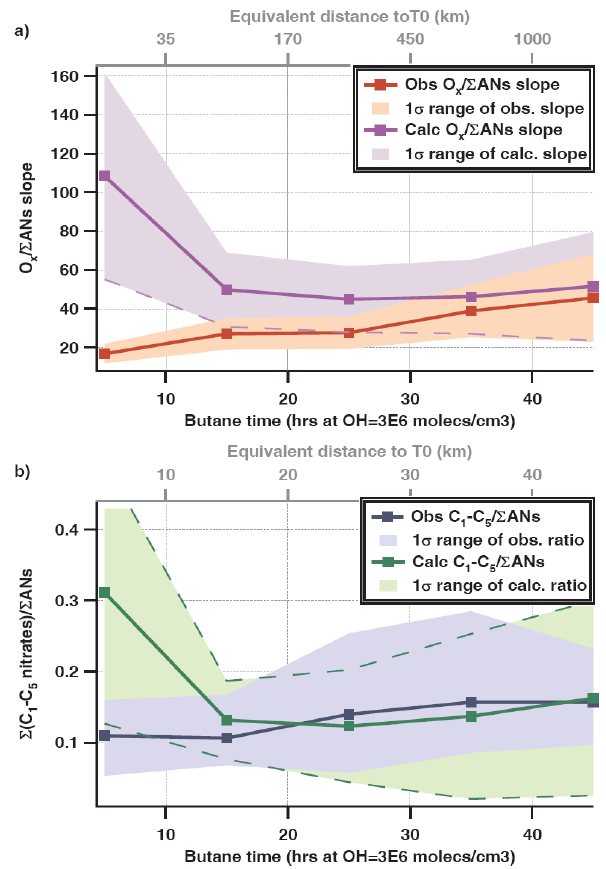
Figure 7a) The observed (red) and calculated (purple) ∑ ANs v. O x slope as a function of 731 Fig. 7. (a) The observed (red) and calculated (purple) 6 ANs v. O x slope as a function of photochemical age. Shaded areas represent photochemical age. Shaded areas represent the 1 σ variation of the data. 7b) The observed 732 the 1 σ variation of the data. (b) The observed (blue) and calculated (blue) and calculated (green) ∑ (C 1 -C 5 nitrates)/ ∑ ANs ratio as a function of 733 (green) 6 (C 1 –C 5 nitrates)/ 6 ANs ratio as a function of photochem- photochemical age. Shaded areas, again, represent the 1 σ variation of the data. 734 ical age. Shaded areas, again, represent the 1 σ variation of the